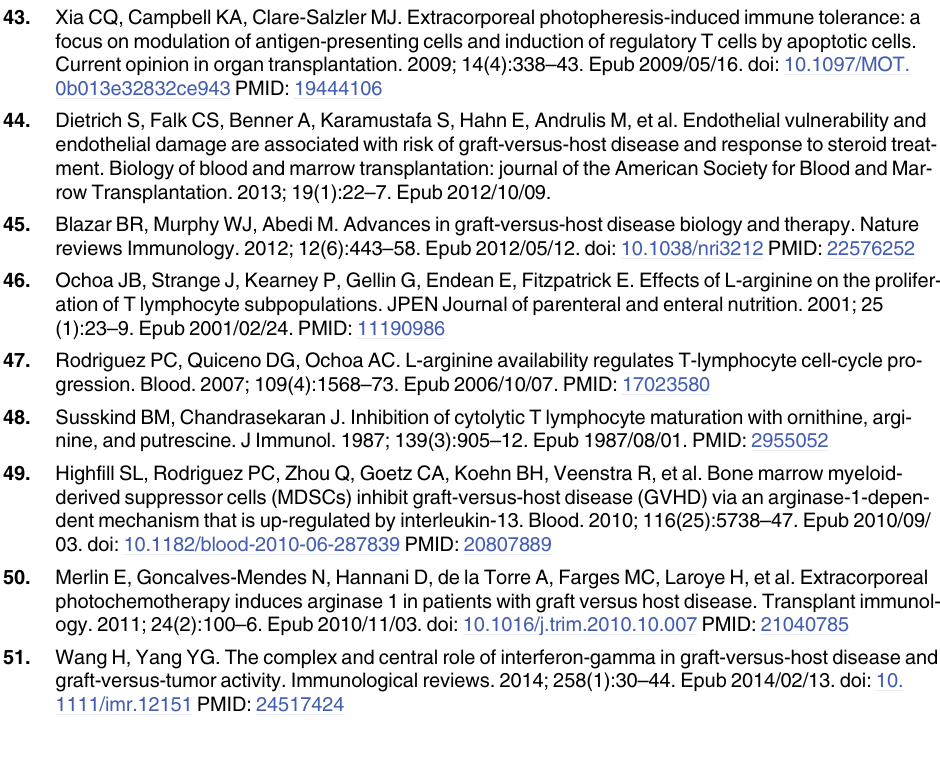
PLOS ONE | DOI:10.1371/journal.pone.0134518 August 4,